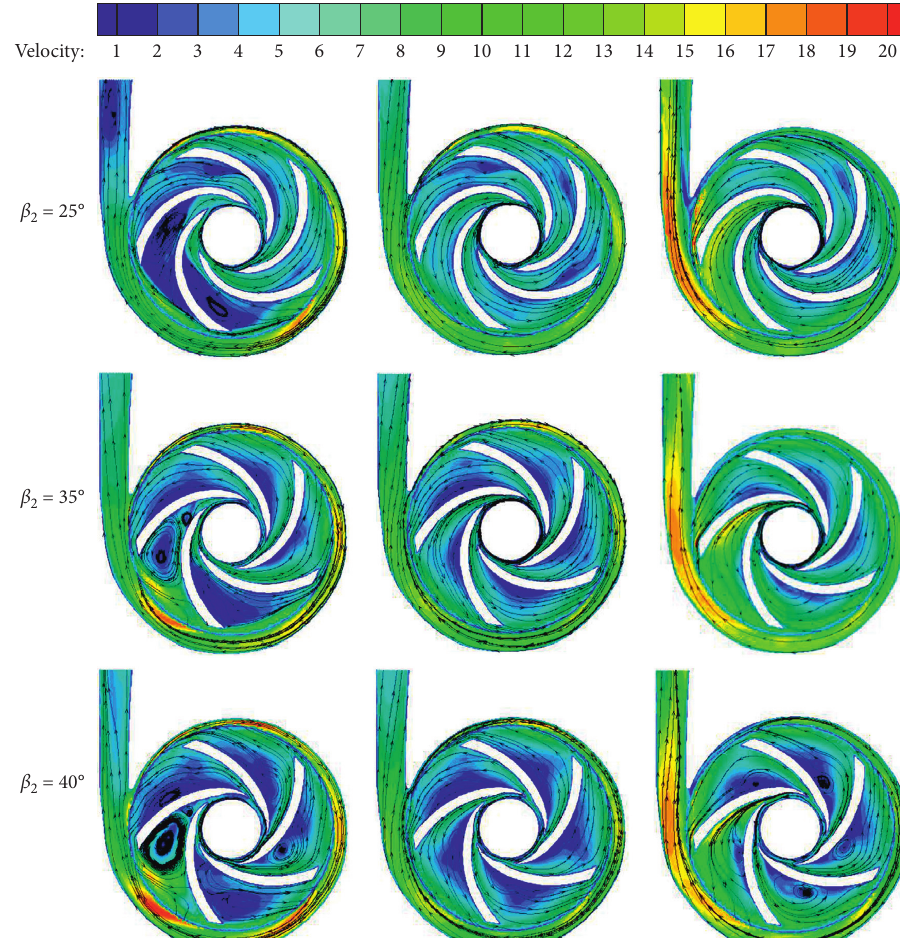
Figure 13: Velocity cloud chart with different outlet angles.